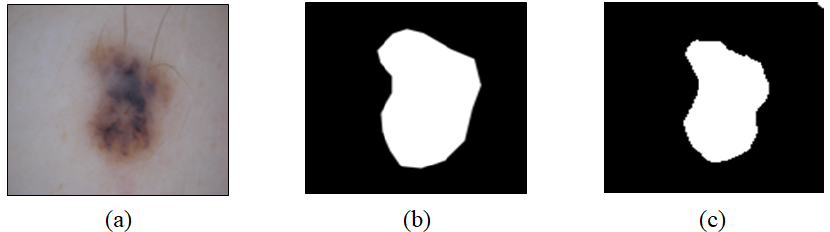
Figure 6. Results of professional labeling and U-Net images obtained based on a dermoscopy image. Images obtained based on ( a ) dermoscopy, ( b ) splitting image, and ( c ) labeling.